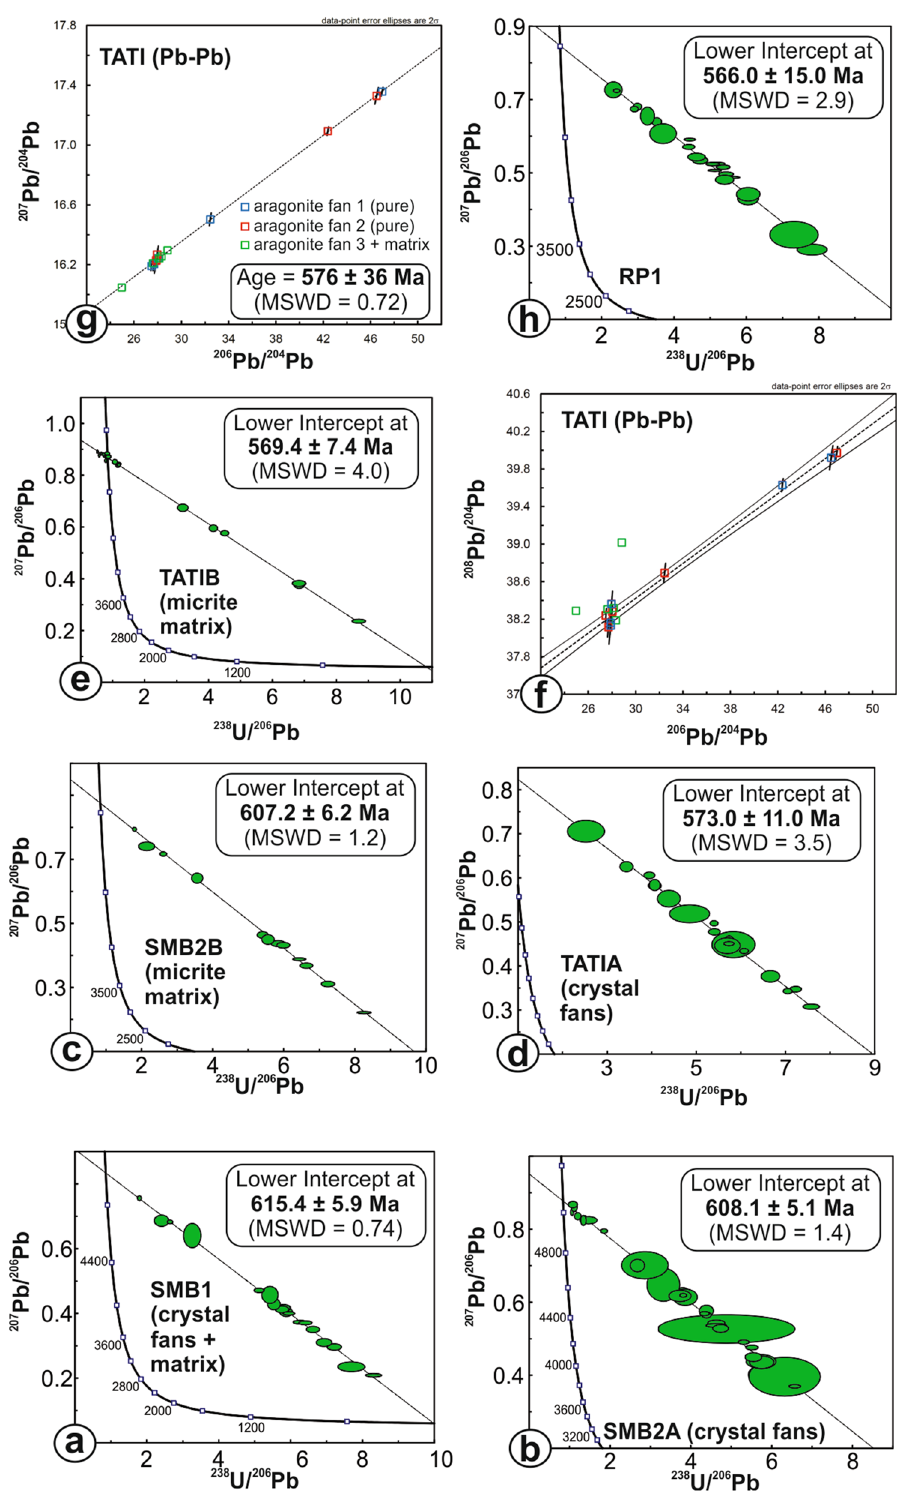
Figure 3. U–Pb and Pb-Pb plots of the analyzed samples. Charts were created using the Isoplot 3.6 Visual Basic Add-in freeware by Ken Ludwig, Berkeley Geochronology Center (http:// www. bgc. org/ isopl ot) for Microsoft Excel (http:// www. micro soft.